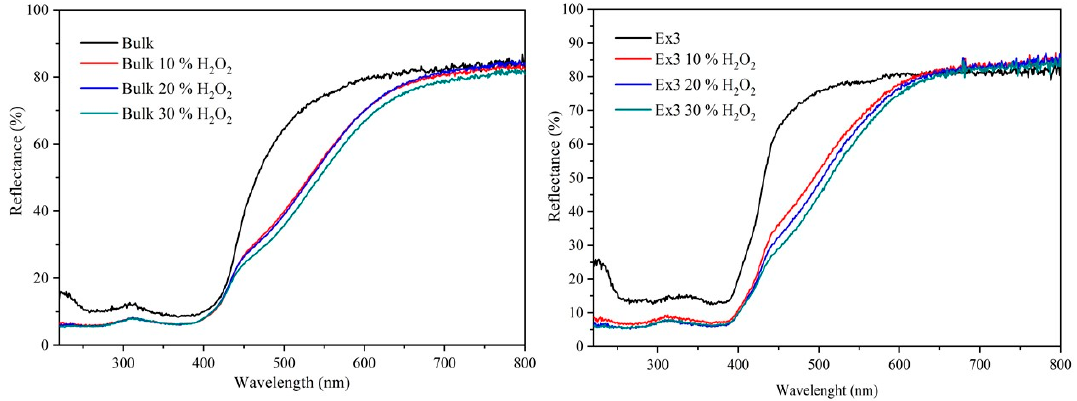
Figure 1. UV-Vis diffuse reflectance spectra of bulk ( left ) and exfoliated GCN nanomaterials ( right ).